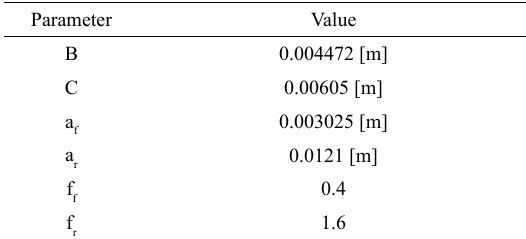
Table 4. Values of the heat source